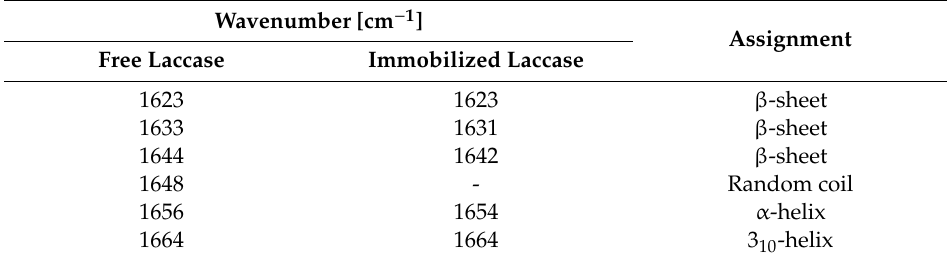
Table 2. Band assignments for free and immobilized laccase in the Amide I infrared region based on Reference